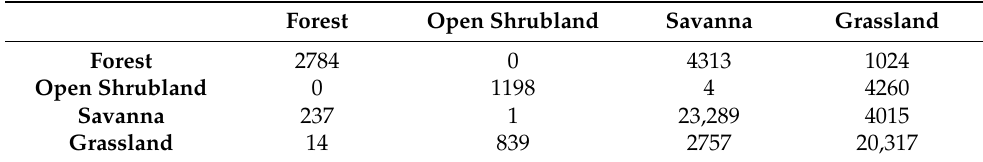
Table 4. Confusion matrix for landcover